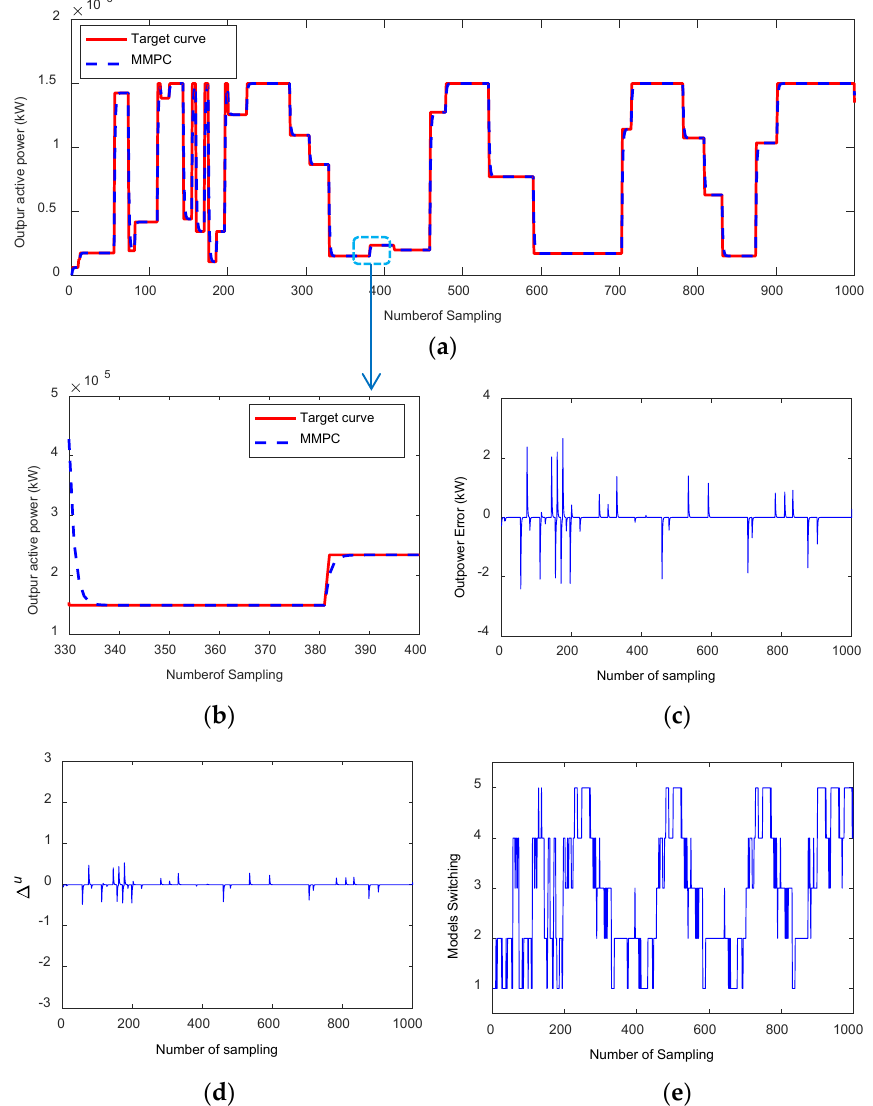
Figure 4. Simulation results using the MMPC. ( a ) The output power of wind farm using MMPC; ( b ) local zoom of ( a ), ( c ) output power error between the target curve and control output, ( d ) control incremental of the single MMPC, ( e ) model selection during the control process.